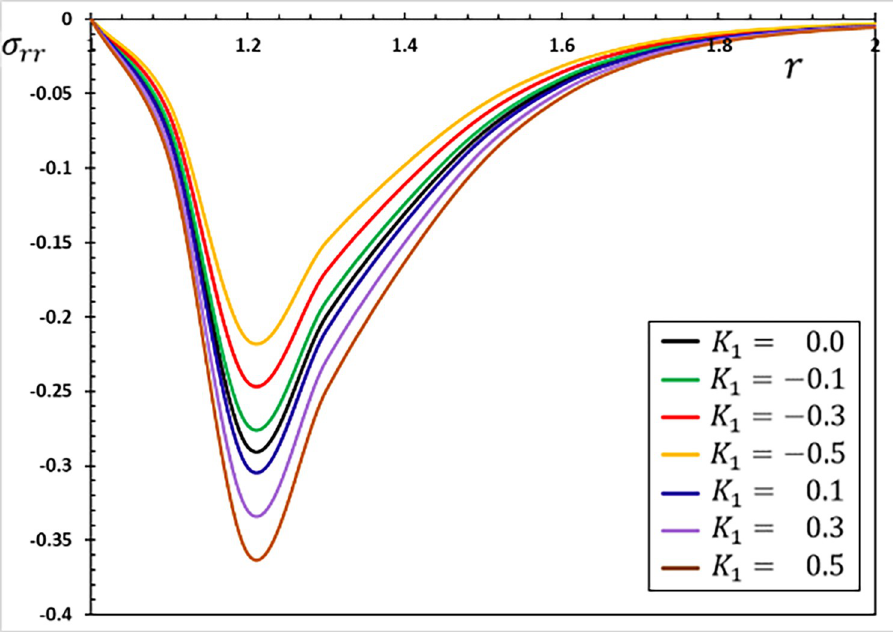
Fig 3. The radial stress variation σ